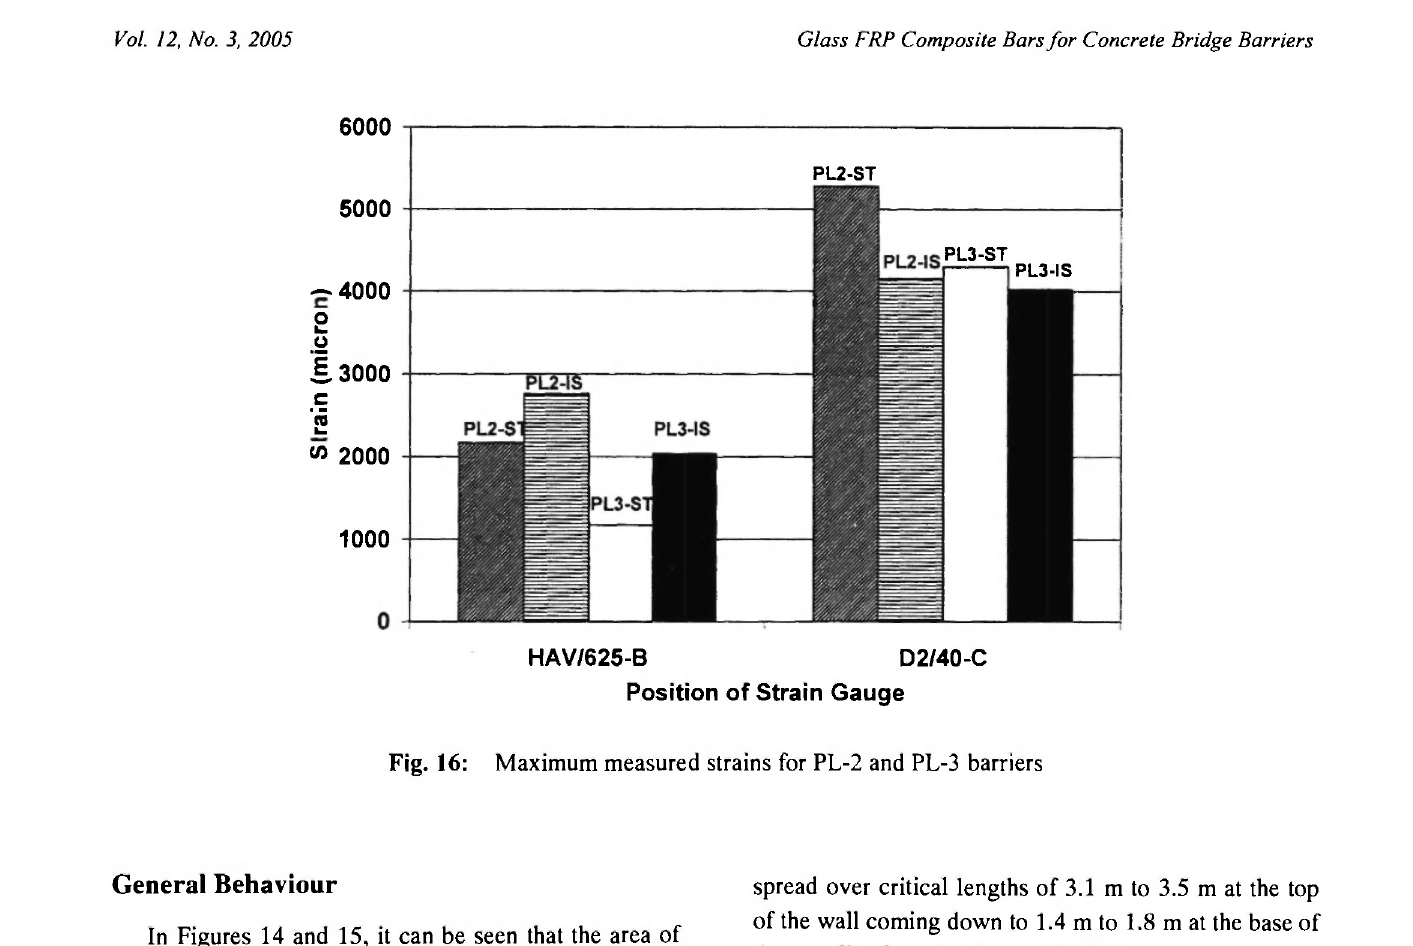
spread over critical lengths of 3.1 m to 3.5 m at the top of the wall coming down to 1.4 m to 1.8 m at the base of the wall for barriers PL2-ST1 and